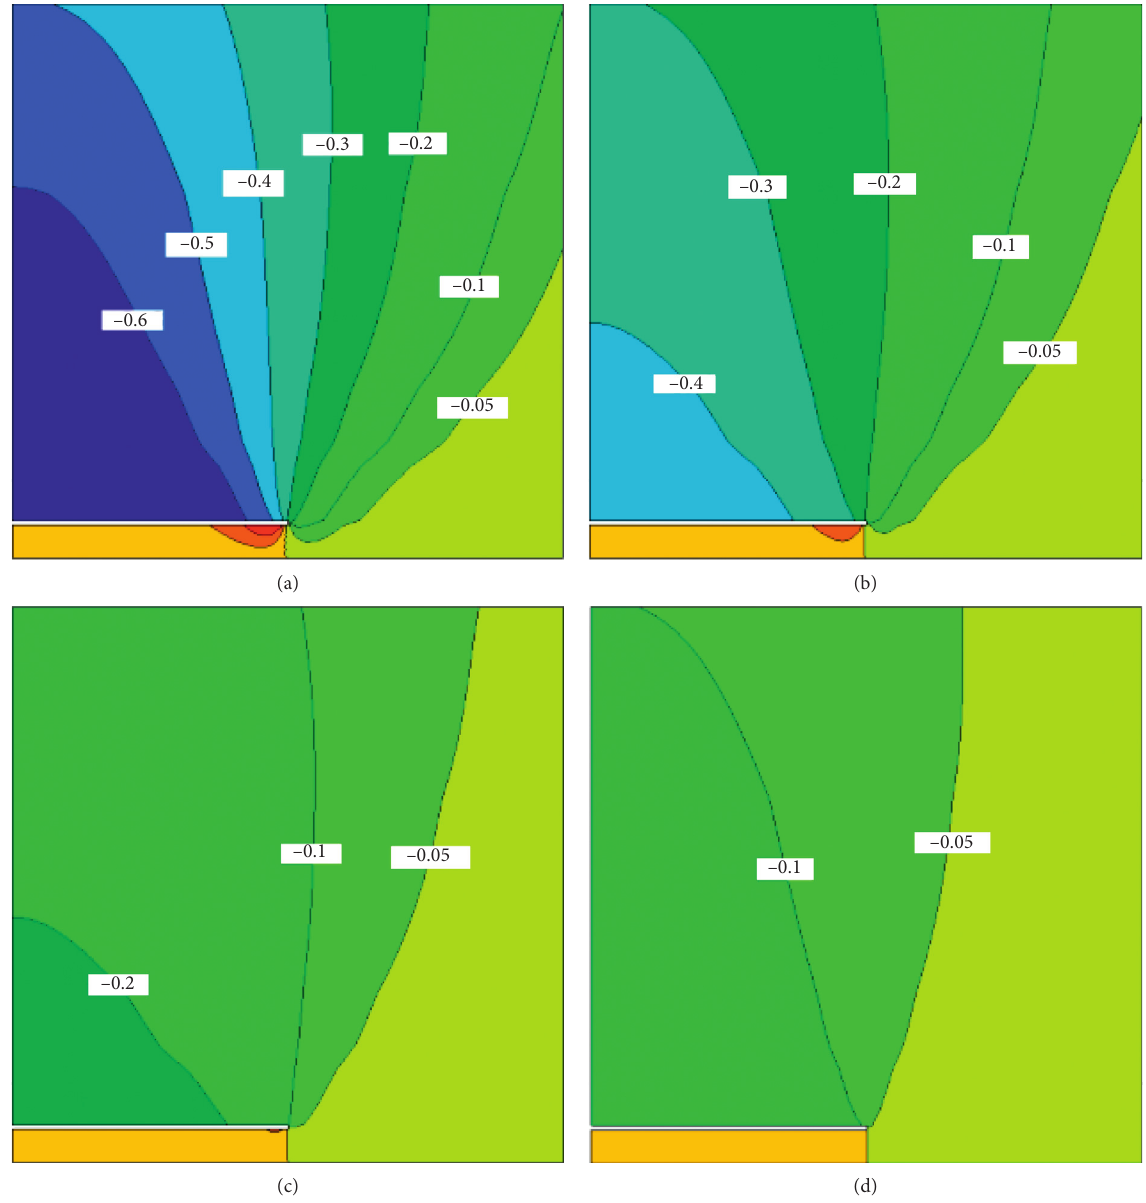
Figure 8: Contour map of vertical displacement of overburden at different initial compaction rates of backfill materials: (a) K K ysini � 0.85; (c) K ysini � 0.75; (d) K ysini �